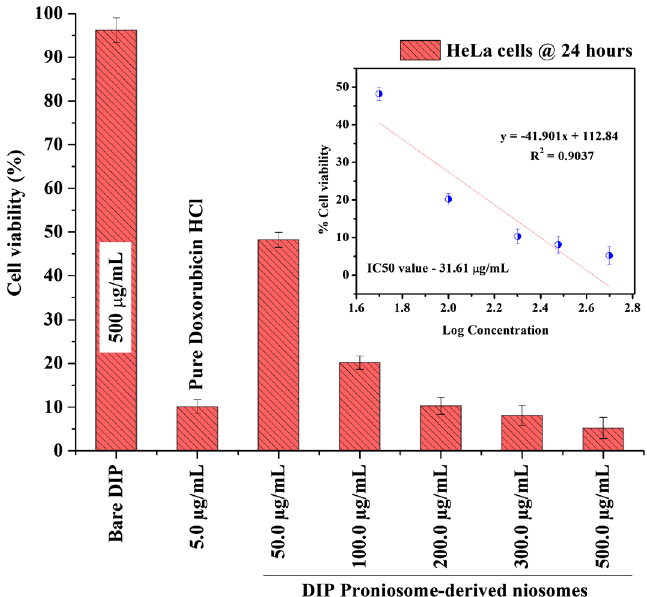
Figure 14. Invitro anticancer activity of DIP proniosomal gel-derived